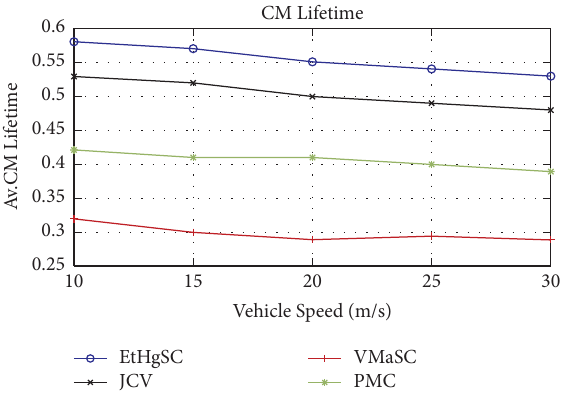
Figure 10: Average CM lifetime at diferent speeds.